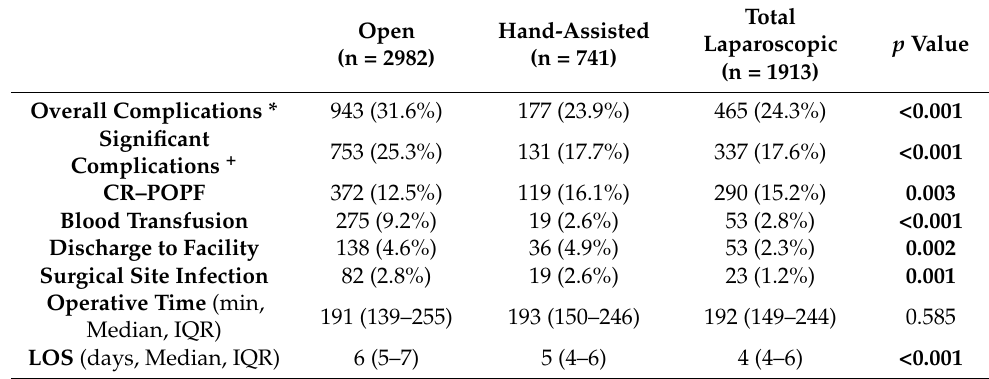
Table 2. Distribution of Outcomes in Patients Undergoing Distal Pancreatectomy by Surgical